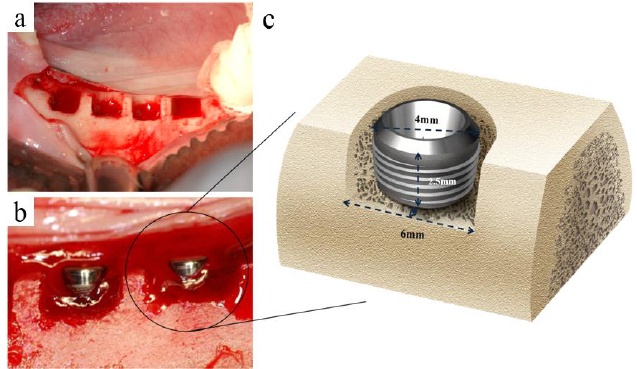
Figure 1. ( a ) Alveolar bone was flattened without exposing cancellous bone; ( b ) 5 mm of implant